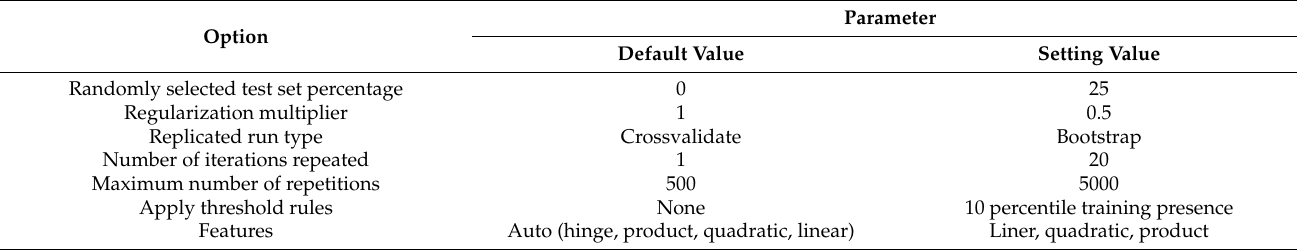
Table 1. Maxent parameter settings.